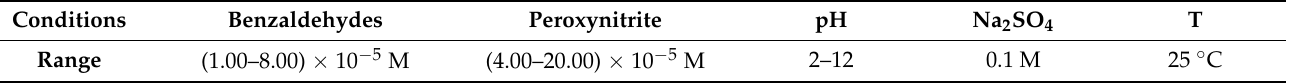
Table 1. Concentration range used in the experimental